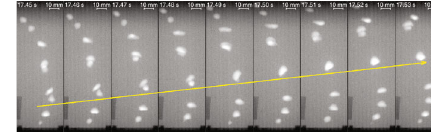
(a) Image from literatures [19], and coalescence events are marked by yellow arrows